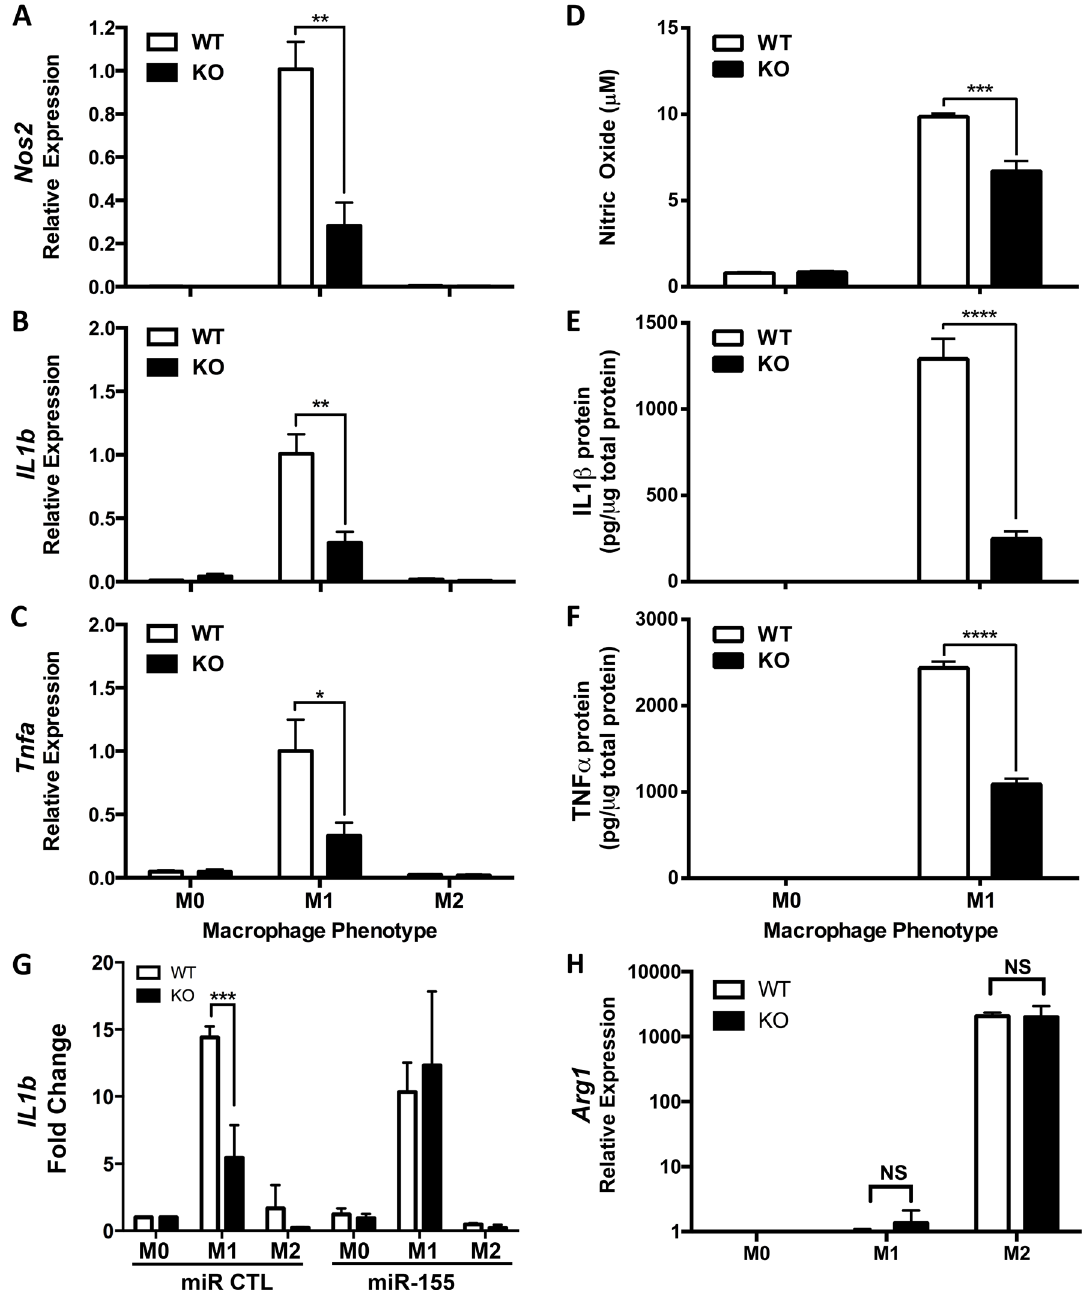
Fig 2. Reduced classically activated M1 marker expression in miR-155 knock-out (KO) macrophages. (A) Inducible nitric oxide synthase ( Nos2 ), (B) IL1b , ( C ) Tumor Necrosis Factor- α ( Tnfa ) (H ) and Arginase-1 ( Arg1 ) expression was determined by Real-Time PCR in wild-type (WT, n = 8 – 11) and miR-155 knockout (KO n = 8 – 12) bone marrow-derived macrophages in vitro activated in M1 or M2 conditions for 24 hours in three independent experiments. Gene expression is expressed as a percentage +/- SEM of the WT M1 condition. Unpaired t-test, * p < 0.05, ** p < 0.005. Relative concentration of (D) nitric oxide (NO), (E) IL-1 β protein and (F) TNF- α protein was determined using Griess assay (for NO) or Bio-Plex Suspension Array (For IL-1 β and TNF- α ) in cell lysates from WT (n = 5) and miR-155 KO (n = 5) bone marrow-derived macrophages in vitro activated in M1 or M2 conditions for 24 hours. Individual protein concentrations expressed as fraction of total protein concentration in either M0 or M1 condition. ( G ) IL1b expression was determined by Real-Time PCR in WT and KO bone marrow-derived macrophages transfected with a scrambled miR control (n = 5) or a miR-155 oligonucleotide mimic (n = 5) and activated in M0 (untreated), M1 (LPS+IFN- γ ) or M2(IL-4) conditions for 24 hours. Gene expression is expressed as a percentage +/- SEM of the scrambled M1 condition. Unpaired t-test, *** p < 0.0005, **** p < 0.00005. (A-G) Data from 2 – 3 independent